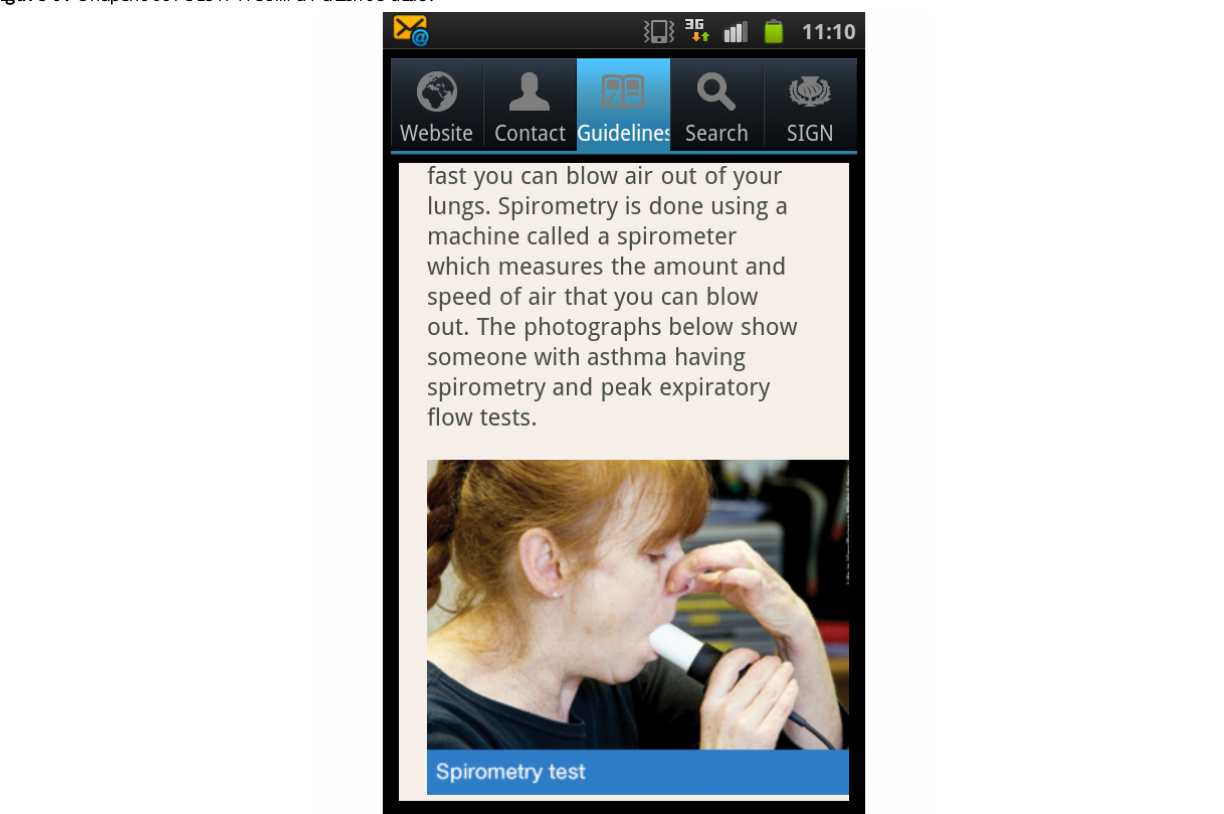
Figure 6. Snapshot of SIGN Asthma Patient